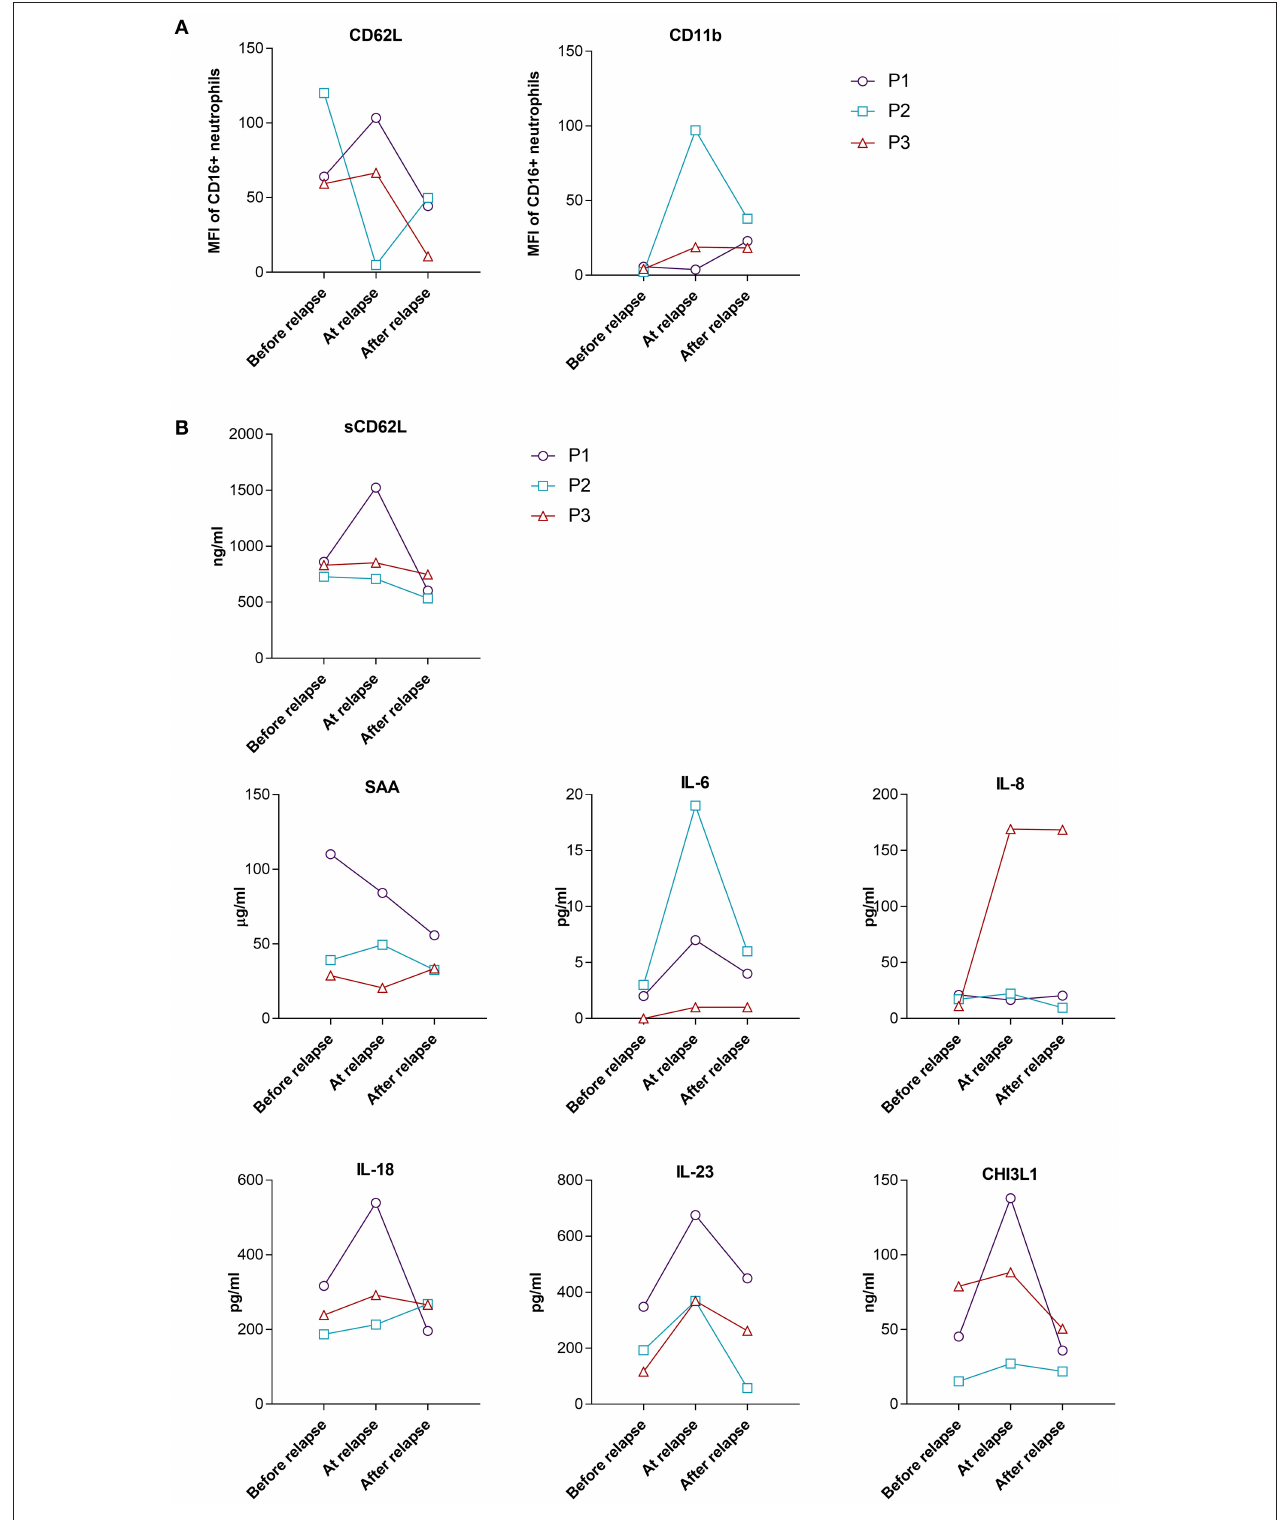
FIGURE 5 | Surface expression of CD62L and CD11b on neutrophils (A) and serum levels of selected analytes (B) from relapsing GCA patients during the 48 weeks of follow-up. Shown are levels/MFI at the last follow-up time point before relapse, at the time point closest to relapse and 12 weeks after relapse. P1 relapsed at week 24, P2 relapsed at week 48 and P3 relapsed at week 12. MFI, median fluorescence intensity, P, patient.